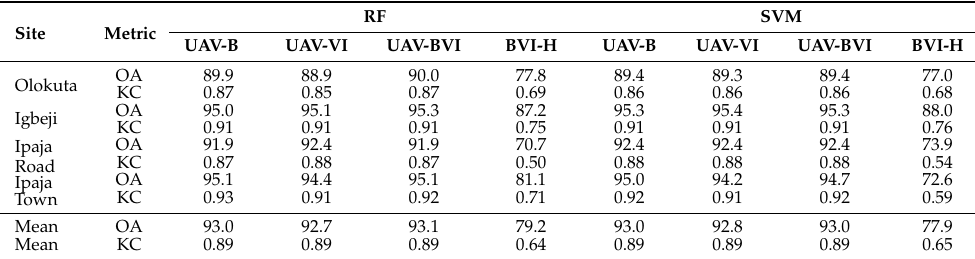
Table 4. Performance of the Random Forest (RF) and Support Vector Machine (SVM) models applied to UAV datasets in four sites in Nigeria.